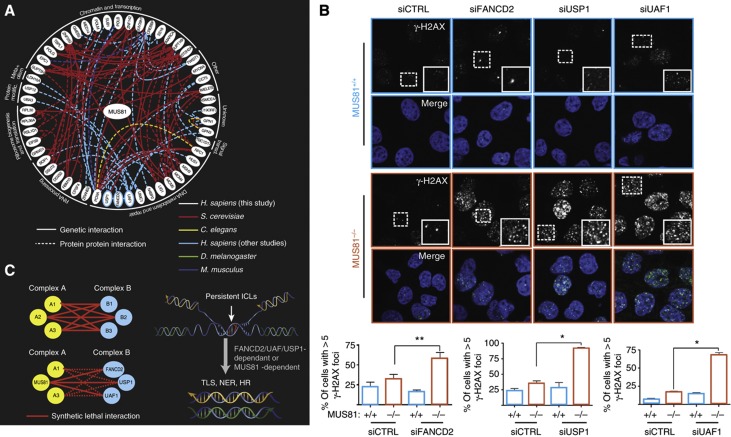
Propagation of MUS81 interaction module using comparative genetics. (A) A subnetwork of genetic and physical interactions between genes identified as negative interactions with MUS81−/− propagated after comparative cross-species analysis. Solid lines represent genetic interactions and dotted lines represent physical interactions. The color of the line indicates which model system the data was derived from (see Supplementary Information for details). (B) HCT116 cells, either MUS81+/+ or MUS81−/− as indicated, were transfected with siRNA against UAF1, USP1 or FANCD2, and stained using an antibody against γ-H2AX after 48 h of knockdown. The corresponding bottom panels show the percentage of cells (n>100) with >5 foci (n=3). **P<0.01 and *P=0.02 using Student's t-test. Scale bar, 12 μm. (C) The left side depicts a model of ‘between-complex' genetic interactions and how MUS81 and FANCD2-UAF1-USP1 fit into this model. This model preserves genomic integrity in the face of persistent interstrand crosslinks or ICLs by providing a genetic buffering mechanism, depicted on the right.